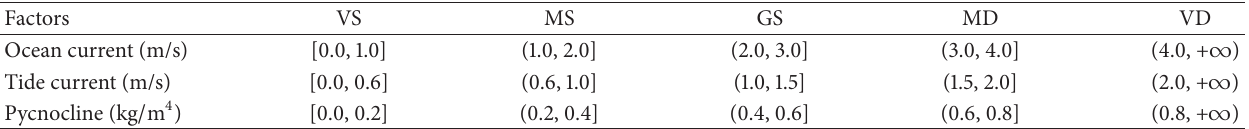
Table 1: The risk